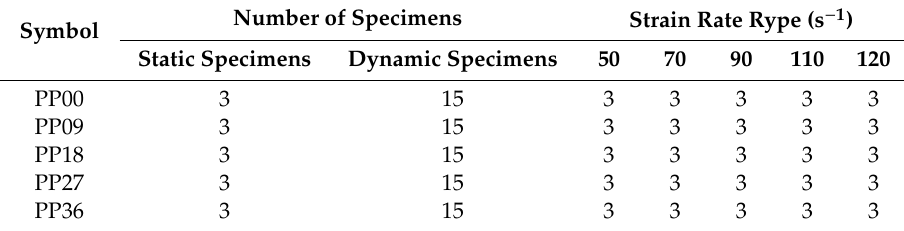
Table 6. Number of static specimens, dynamic specimens and strain